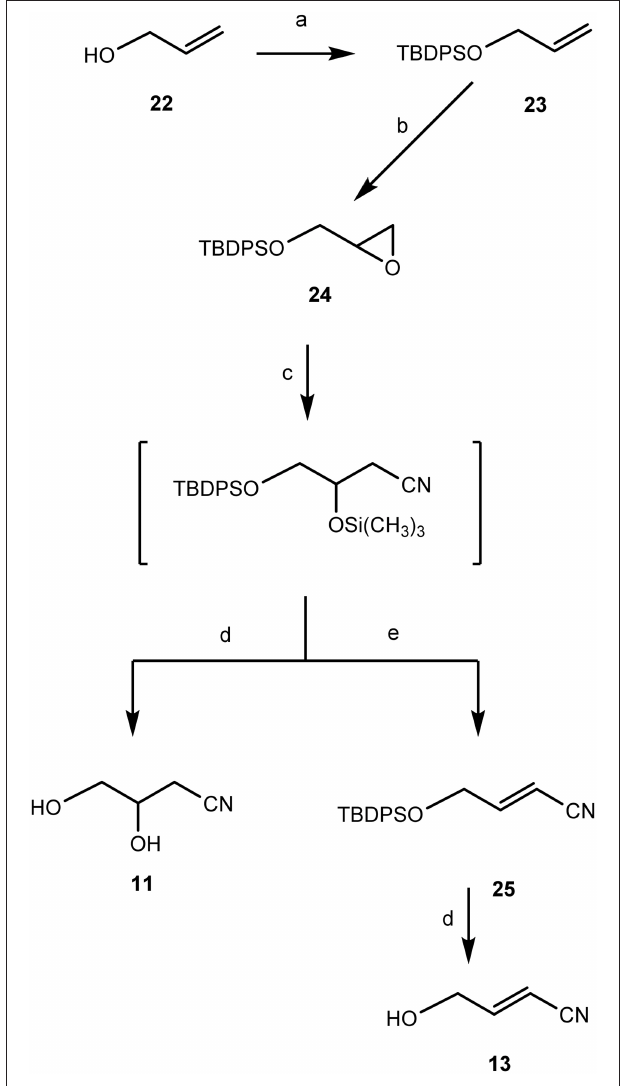
FIGURE 10 | Chemical synthesis of 3,4-dihydroxybutanenitrile (11) and ( E )-4-hydroxy-2-butenenitrile (13). Reagents and conditions : (a) TEA, DMAP, TBDPSiCl, CH 2 Cl 2 , r.t., 1h, 97%; (b) m -CPBA, ClCH 2 CH 2 Cl, 85 ◦ C, 30min, 95%; (c) Trimethylsilyl cyanide [TMSCN: (CH 3 ) 3 SiCN], solid